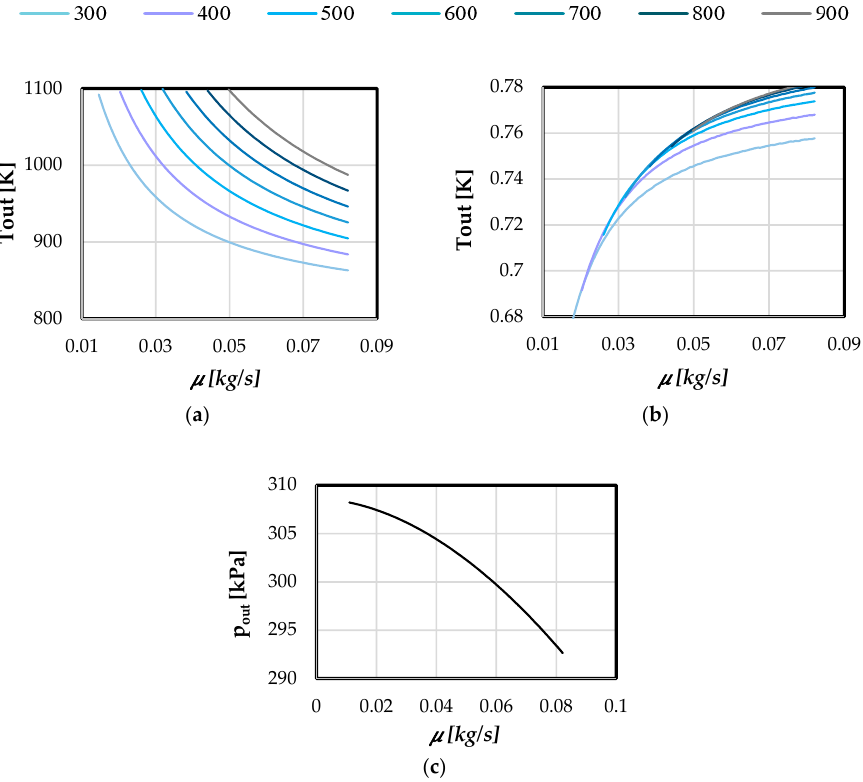
Figure A3. Receiver characteristic maps: variation of outlet temperature ( a ), efficiency ( b ) and pressure drop ( c ) with air corrected mass flow rate.